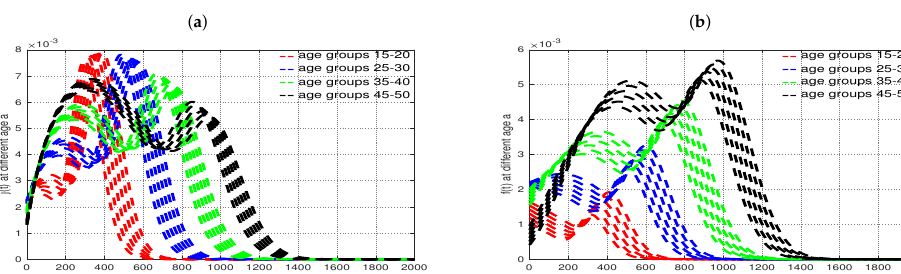
Figure 4. Solution profiles of the densities of unprotected susceptible individuals, protected suscepti- ble individuals, symptomatic or confirmed HIV-infectious and AIDS population at age groups (unit is year ) 15 ∼ 20, 25 ∼ 30, 35 ∼ 40, 45 ∼ 50, respectively when R 0 = 0.8878 < 1: ( a ) the distributions of j ( t , a ) at different age groups; ( b ) the distributions of f ( t , a ) at different age groups. Example 2. The persistence of disease, the stability of the endemic steady state of model (4)